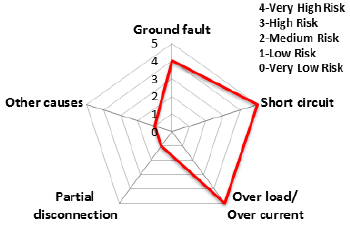
Figure 15. The risk rating for electrical fires in Gwangju. Figure 16. The risk rating for electrical fires in Incheon. So far, we have analyzed the annual electrical fires in each region and correlated them with monthly climate change variables. In addition, annual fires by cause in each region are analyzed. By integrating electric fires by region into the monthly climate variables, accumulated for 10 years (from 2006 to 2015) of statistics, the average number of electrical fires in each region in each month can be represented. Figure 17 shows the monthly electrical fires by region in the form of matrix diagram [12] that indicates the correlation between the climate variables and the electrical fires. This diagram shows the risk level of electrical fires in any month of the year in each region. The redder the color in the matrix, the higher the risk is. On the other hand, the more yellow the color is, the lower the risk is. Figure 17. Risk matrix diagram for electrical fires by region and month. Seoul Busan Incheon Daejeon Daegu Gw angju Gangw on Jeju